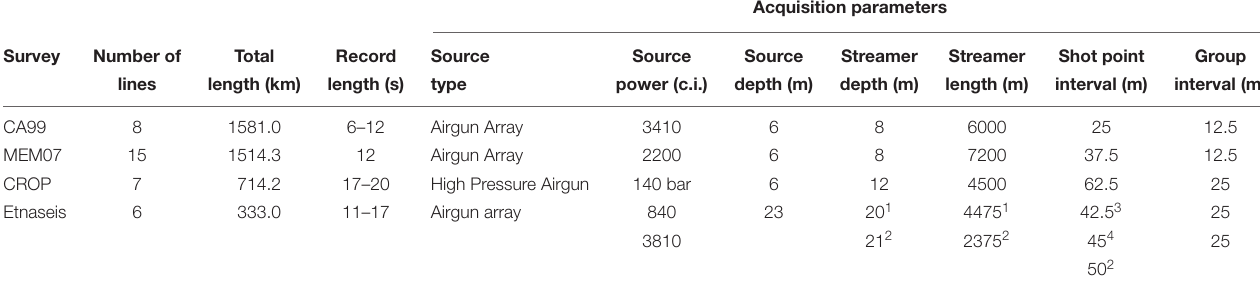
TABLE 1 | Characteristics of the seismic reflection